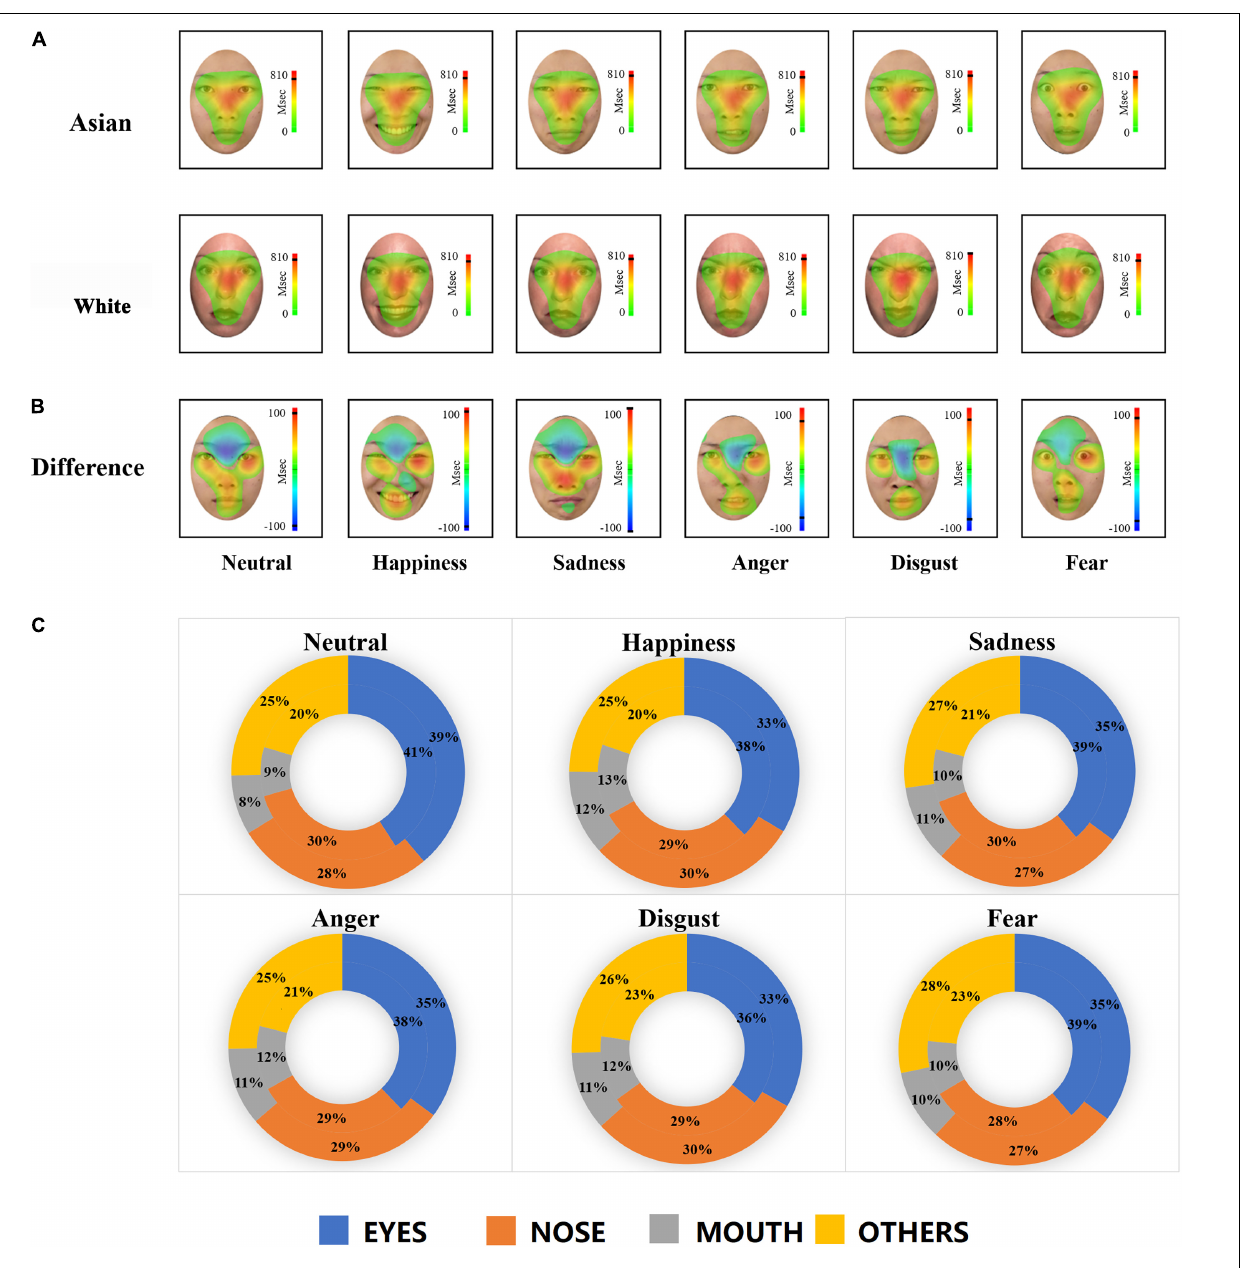
FIGURE 4 | Heat maps and doughnut diagrams of fixation distributions on Asian and White facial expressions. (A) Heat map of fixation distributions for each facial expression in Asian (top) and White (bottom) faces. Color-coded distributions represent the duration of fixations across face regions, with red indicating higher fixation proportions. (B) Heat map of differences between Asian faces and White faces for each expression. Color-coded distributions represent the different duration of fixations across face regions, with red indicating the regions where Asian faces were fixated more than White faces and blue indicating the opposite pattern. A black line is drawn on the heat map scale to indicate the actual maximum activation of the heat map. A default low activity cut-off value (10%) is used on both sides of the scale so that no coloring is applied when the difference is small. (C) Doughnut of fixation distributions including eyes (total of the left eye and right eye), nose, mouth, and rest of the facial regions across expression and face race. The outer lane indicates the pattern for White faces and the inner lane for Asian faces. p (eyes) = p (left eye) + p (right eye); p (others) = 1- p (eyes)- p (nose)- p (mouth).